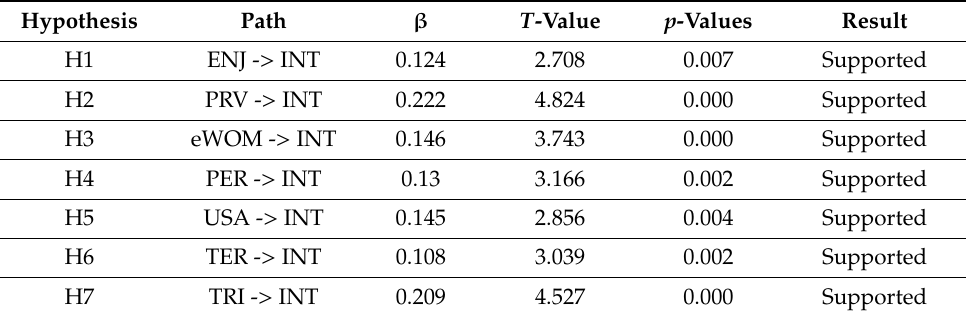
Figure 2. Path analysis, * p -value < 0.000, ** p -value < 0.01. Table 9. Structural model